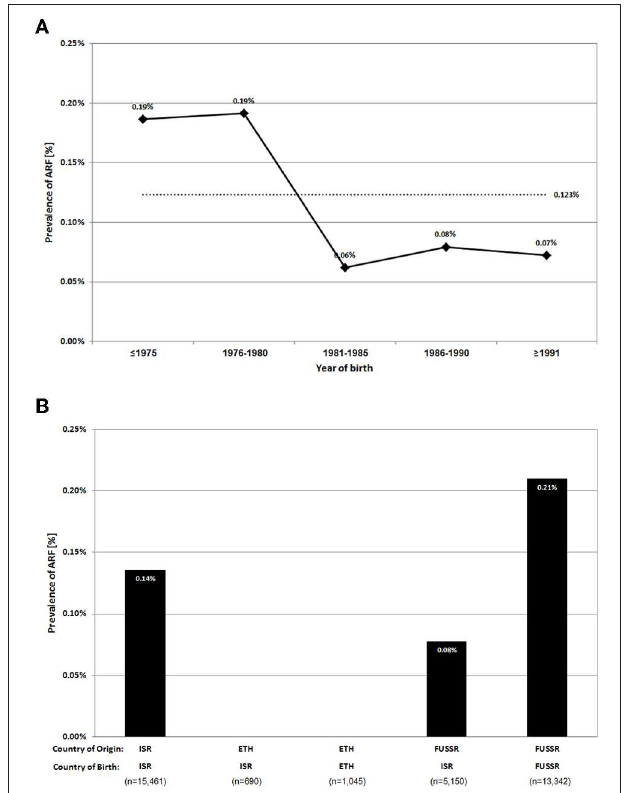
FIGURE 1 | Secular trends of ARF prevalence among whole study population (A) (The overall prevalence is indicated by a dashed line) and ARF prevalence among specific sub-populations, stratified by country of origin and country of birth (B)